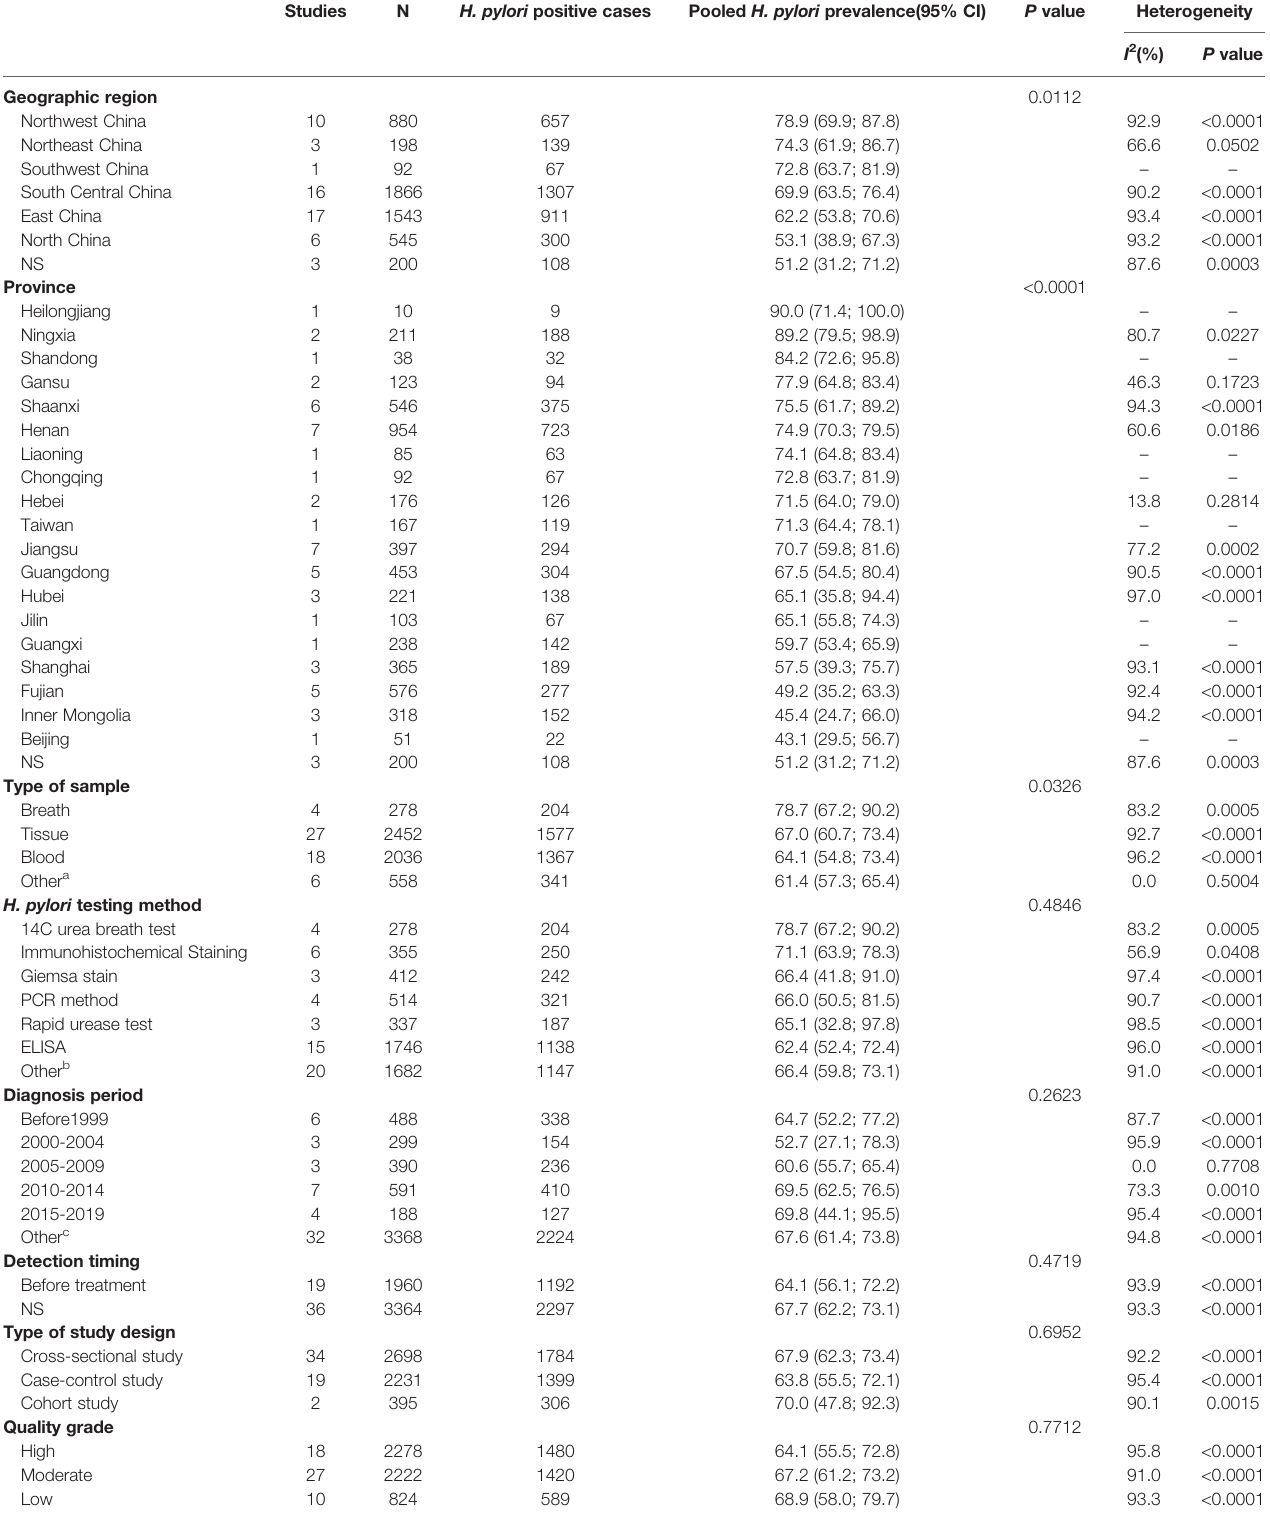
TABLE 1 | Prevalence of Helicobacter pylori in non-cardia gastric cancer by strati fi cation